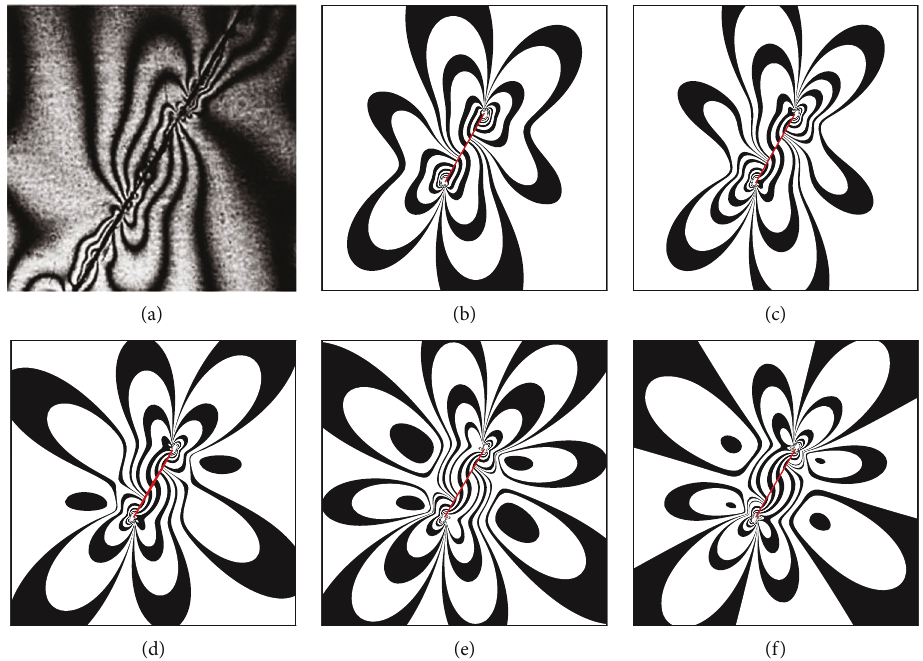
Figure 14: The comparison of isochromatic fringe patterns obtained from experiment and model: (a) the results of photoelastic experiment [37]; the results of the proposed model: (b) Δ a / a = 0 ; (c) Δ a / a = 0 : 25 ; (d) Δ a / a = 0 : 5 ; (e) Δ a / a = 0 : 75 ; and (f) Δ a / a = 1